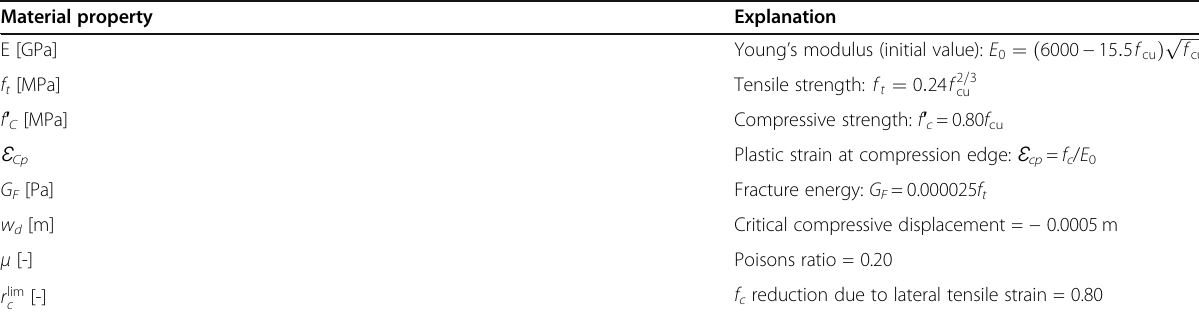
Table 1 Material parameters for concrete (reference [18]) Material property